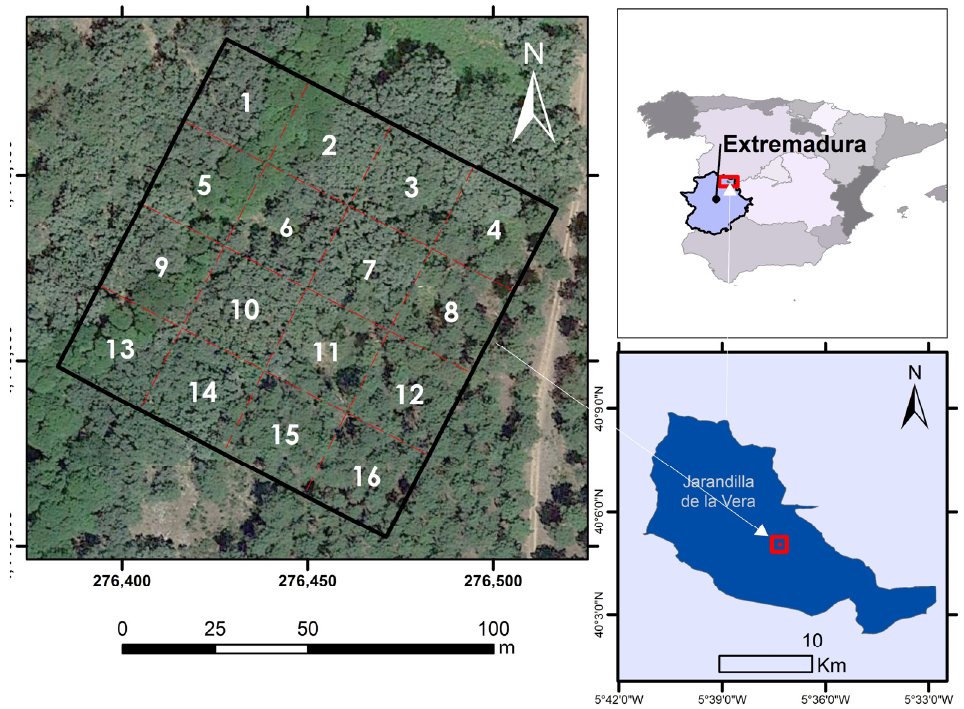
Figure 1. Location of the study area in Jarandilla de la Vera, northern region of Extremadura in West Spain. The boundaries of 16 sections conforming the marteloscope (100 m side) are labelled and displayed in light red (left). The background is a drone-based aerial imagery collected during the measuring of tree reference data in leaf-on conditions (25 May 2022). The distribution of black alder ( Alnus glutinosa ) within the site follows, on the western sections, the crossing of the stream along sections 1, 5, 9 and 13. Table 1. Summary of the forest inventory data including tree variables, range and mean values for each of the three species included in the 1 ha marteloscope